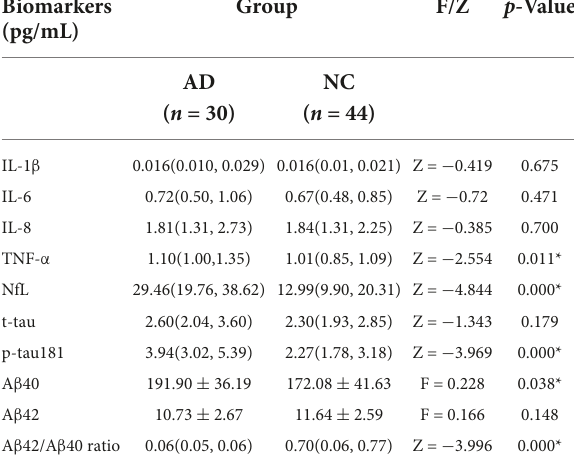
TABLE 2 Expression levels of plasma ANT biomarkers and inflammatory